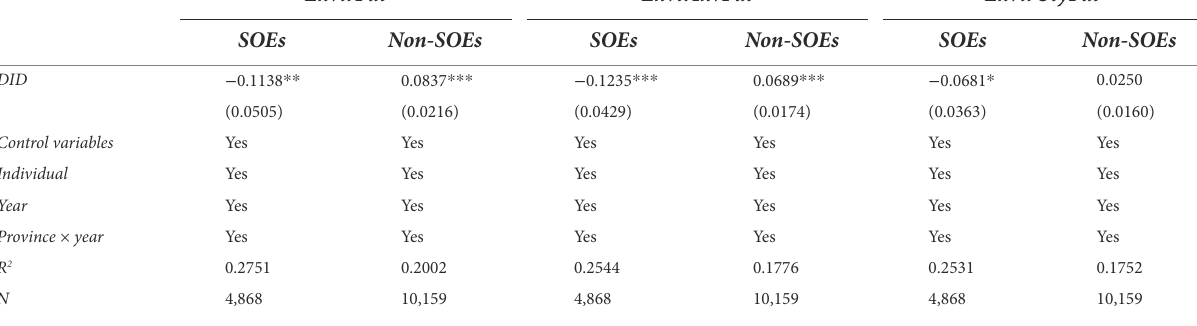
TABLE 8 The heterogeneity of enterprise